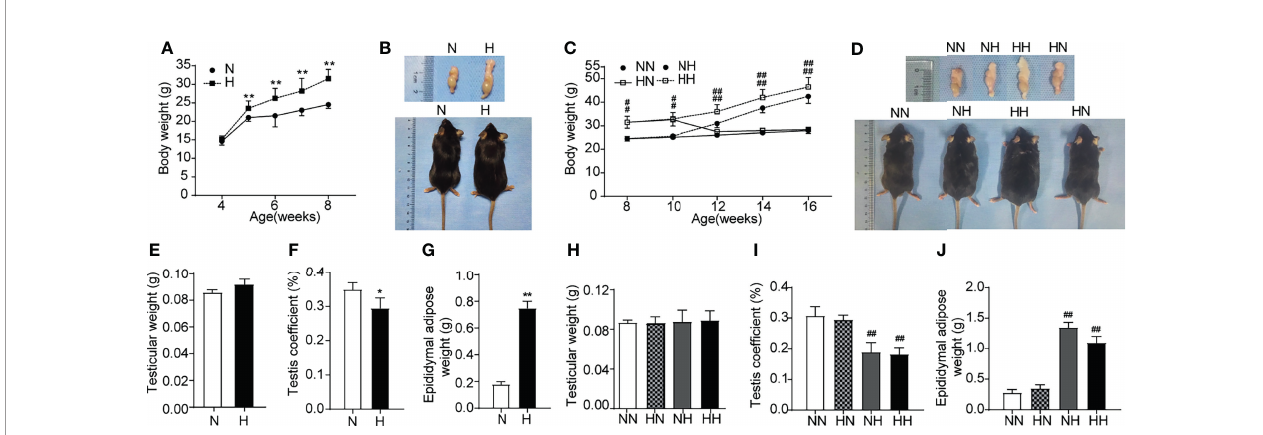
FIGURE 1 | General conditions induced by high-fat diet during sexual development (A) Comparison of time-dependent changes in body weight between normal diet (N) and high-fat diet (H) group of 8-week age mice (n= 8 for each group). (B) Representative gross inspection of normal diet of (N) and H group at the 8th week. (C) . Comparison of time-dependent changes in body weight among NN group, HN group, NH group and HH group at 16th week (n=8 for each group). (D) Representative gross inspection of NN group, HN group, NH group and HH group at the 16th week. (E) testicular weight and (F) testicular coef fi cient and (G) epididymal adipose in normal diet group (N) and high-fat diet group (H) of 8th week of feeding (n=8 for each group). The comparison of (H) testicular weight and (I) testicular coef fi cient and (J) epididymal adipose among NN group, HN group, NH group and HH group at 16th week (n= 3 for each group). Results are presented as mean ± SEM. *p < 0.05, **p < 0.01 vs the N group. #p < 0.05, ##p < 0.01 vs the NN